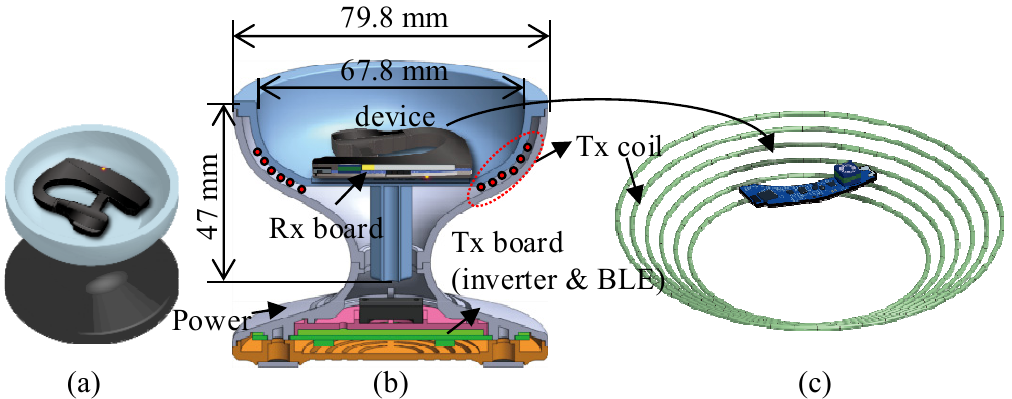
Figure 1. ( a ) Illustration of the wireless charging station of a wearable bio-signal monitoring device; ( b ) the cross-sectional view; ( c ) the transmitting coil used in the charging station.